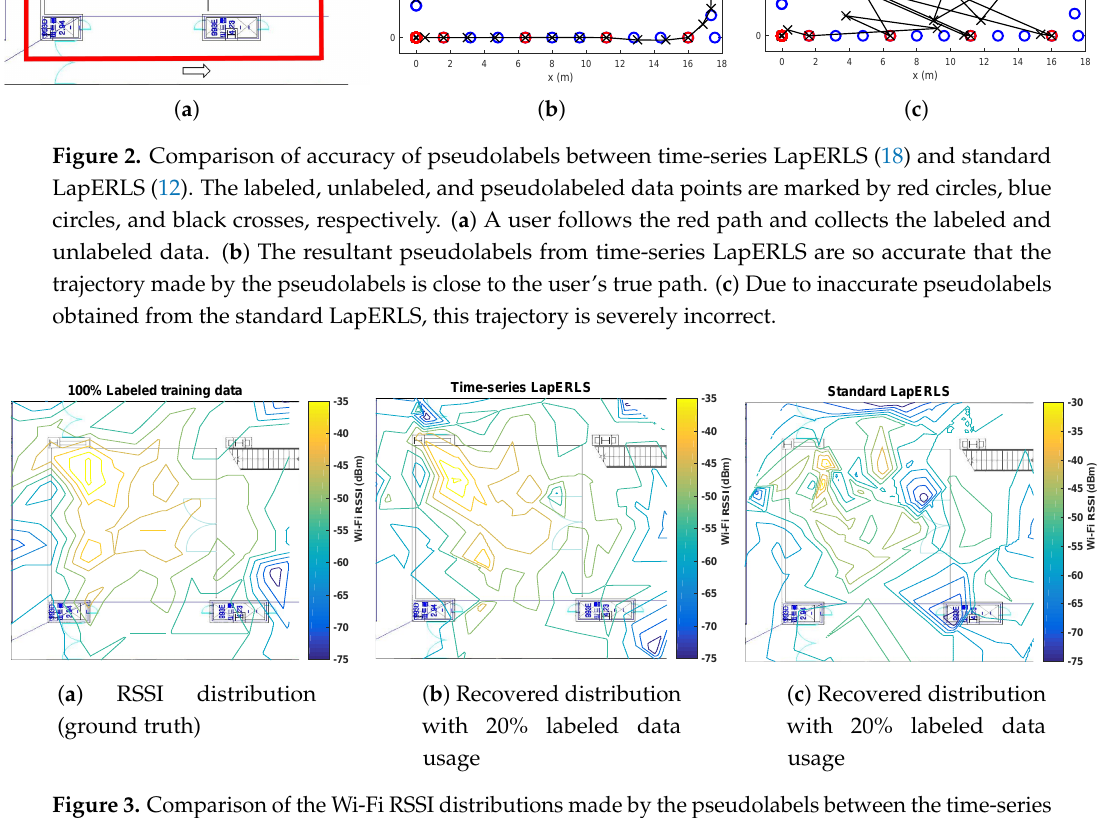
Figure 3. Comparison of the Wi-Fi RSSI distributions made by the pseudolabels between the time-series LapERLS (proposed) and the standard LapERLS (compared). In ( a ), the original RSSI distribution sent from #3 access point marked in Figure 1 is given as the ground truth and is made by using the entire labeled training data. In ( b ), the time-series LapERLS algorithm with usage of 20% of the labeled training data produces the similar distribution to the original distribution due to the accurately estimated pseudolabels. In ( c ), the standard LapERLS with usage of 20% labeled training data produces the severely distorted